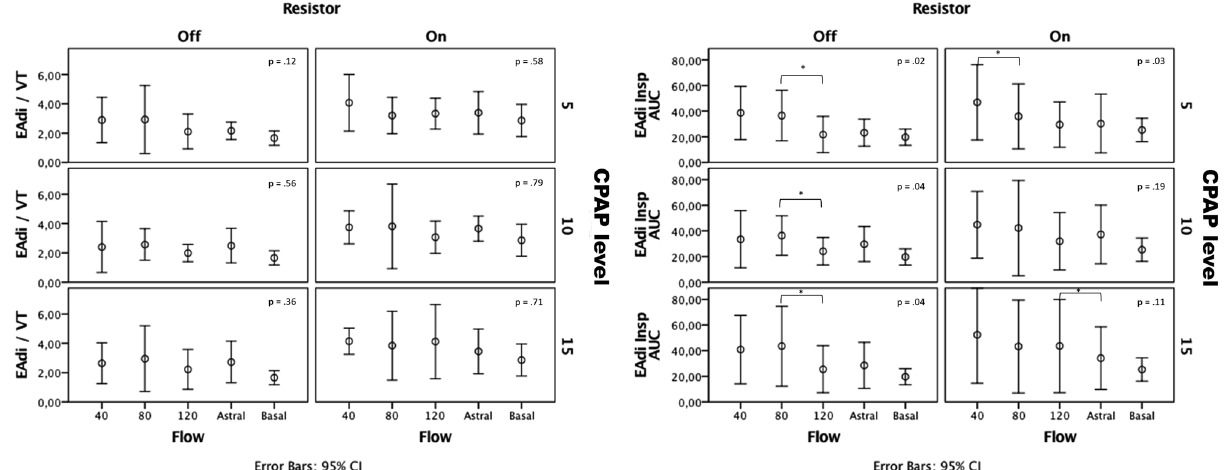
Figure 2. Electrical diaphragm effort. EAdi/V T, electrical diaphragm activity area of the inspiratory phase normalized for the tidal volume (V T ); EAdi Insp AUC, electrical diaphragm activity area of the inspiratory